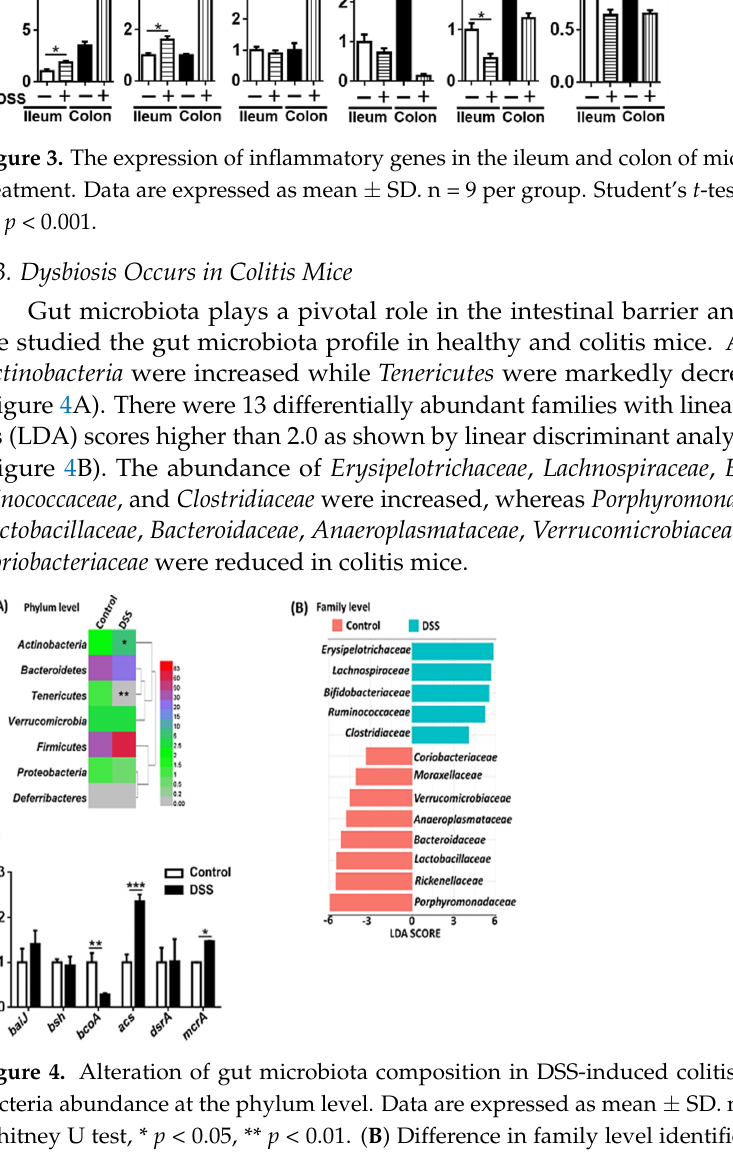
Figure 2 . ( A ) Alpha diversity index from 16S rRNA sequencing, ( B ) Principal coordinates analysis (PCoA) plot of the Bray-Curtis dissimilarities of cecal microbiota 16S rRNA profiling Control and DSS treated mice (n = 3/group) at the family ( C ) and genus level.